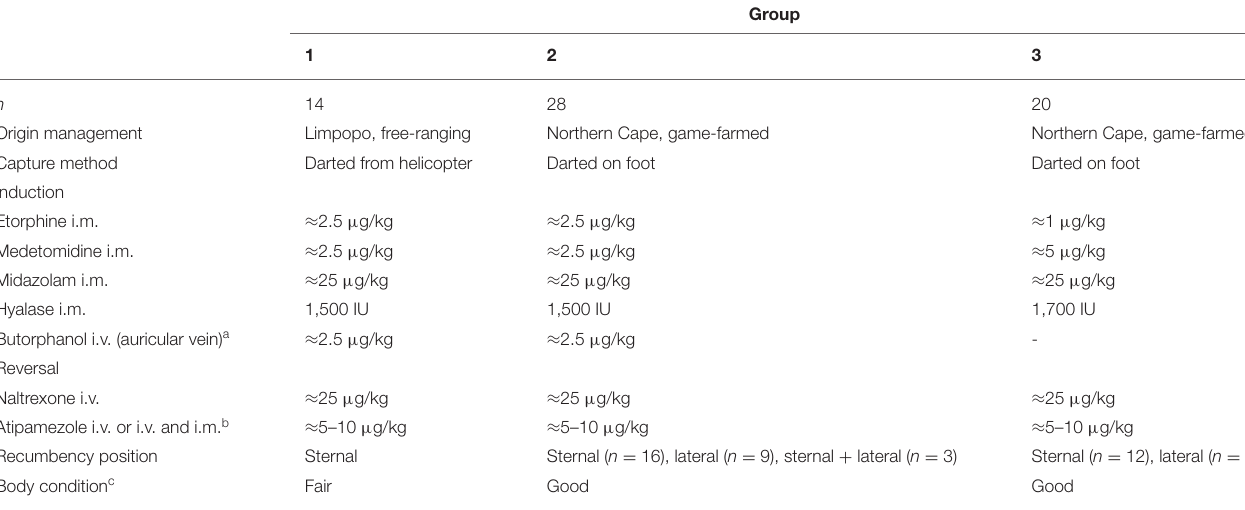
TABLE 1 | Immobilization protocols of free-ranging (Limpopo Province) and game-farmed (Northern Cape) rhinoceroses, showing capture method, drug doses, and routes of administration (i.m., intramuscularly; i.v., intravenously) in Groups 1, 2, and 3 with n = number of